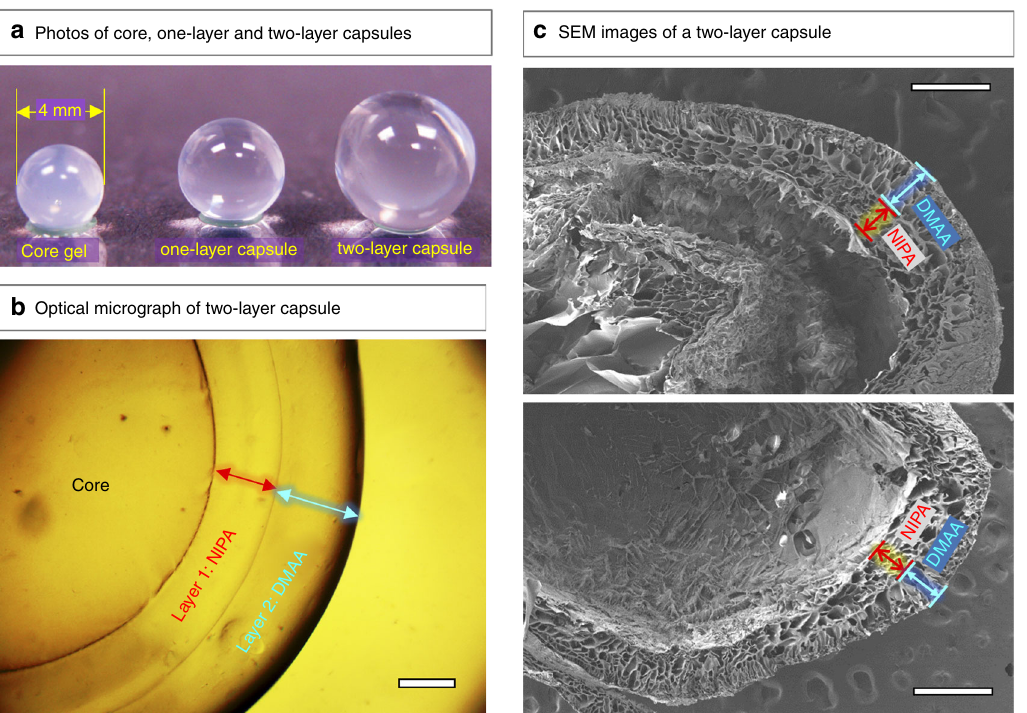
Fig. 2 Images of multilayer capsules at different length scales. ( a ) Photos of the alginate gel core and the corresponding one-layer and two-layer capsules. ( b ) Optical micrograph of a capsule with an alginate (Alg) core, an inner layer of N-isopropylacrylamide (NIPA) and an outer layer of N,N ′ -dimethylacrylamide (DMAA). The overall structure is denoted as Alg – NIPA – DMAA. The scale bar is 500 µ m. ( c ) Scanning electron micrographs of two Alg – NIPA – DMAA capsules (after freeze-drying). The boundaries between the layers can be distinctly seen in both cases. Scale bars in the images are 500 µ